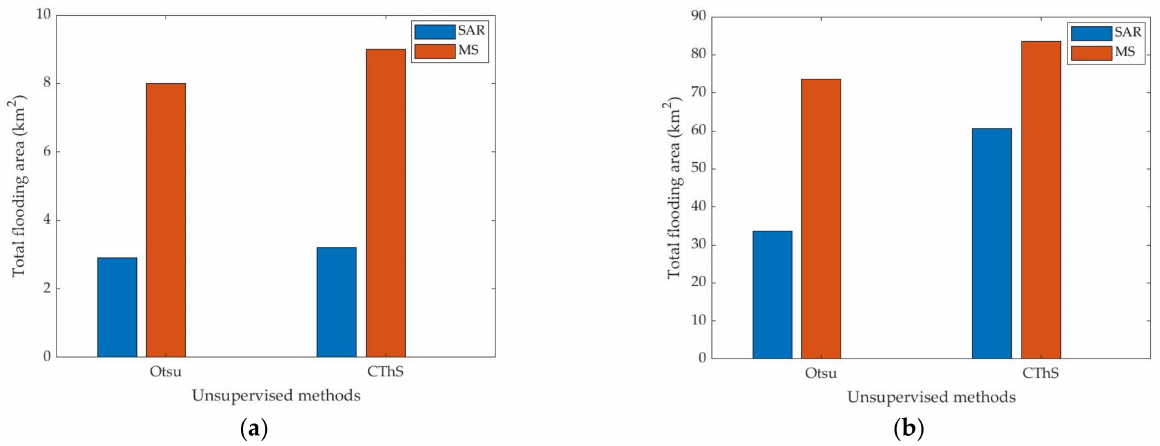
Figure 7. Total flooded areas estimated with Otsu and CThS methods using SAR and multi-spectral data for the events ( a ) 2017, Enza river and ( b ) 2020, Sessia river. Table 3. Confusion matrices of the RF classification results of the flood event 2020 using SAR, MS, and the combination of them. Emergent Vegetation Turbid Water Clear Water Vegetation